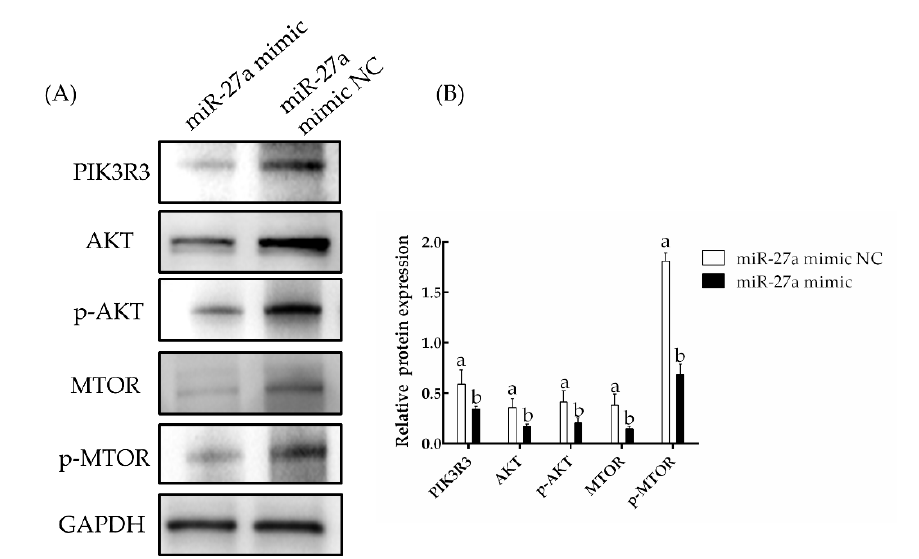
Figure 7. The effect of miR-27a mimic transfection on the expression and activation of proteins in the MTOR/AKT signaling pathway was determined by Western blotting. ( A ) Proteins were extracted 48 h after transfection with an miR-27a mimic or a negative control (NC) and analyzed with the noted antibodies. ( B ) The band densities in panel ( A ) were quantified with Image J. The different small letters (a, b) in the same graph indicate that the difference between groups is statistically significant ( p < 0.05).